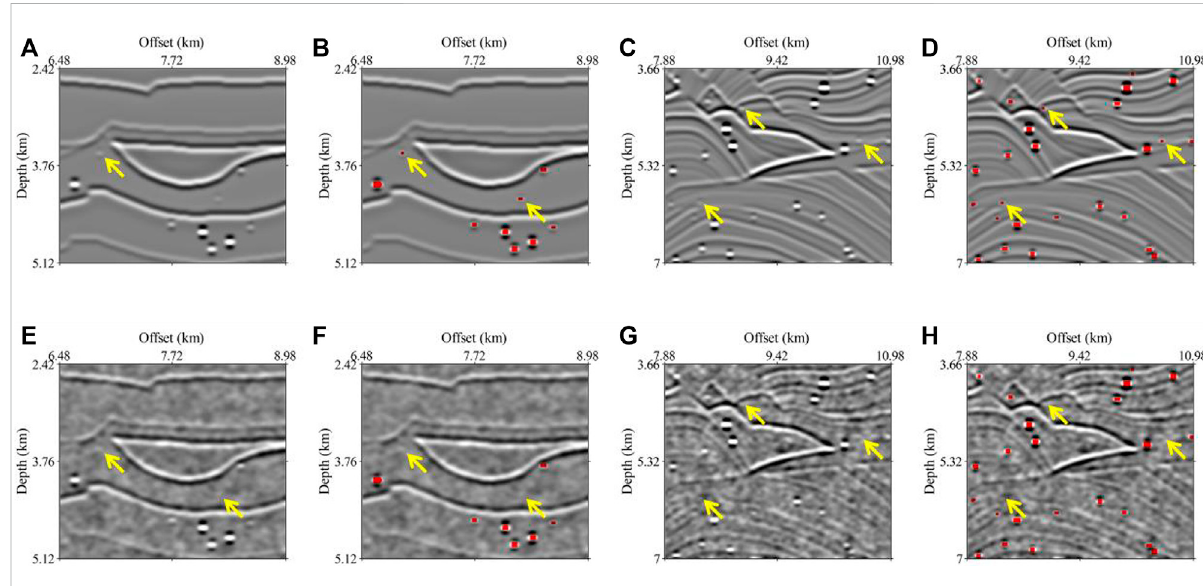
FIGURE 10 An enlarged view of the area selected by the yellow dotted line in Figure 9 and Figure 8.